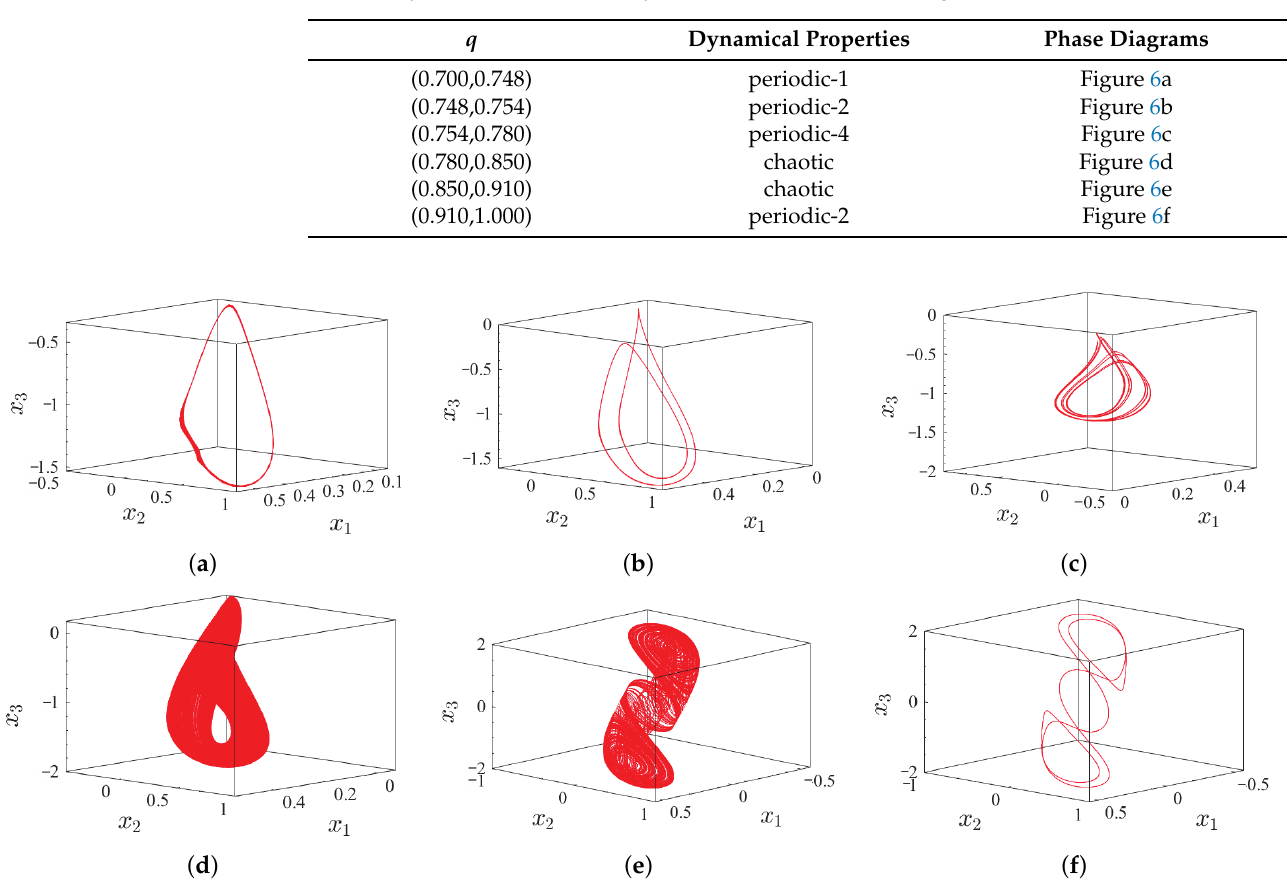
Figure 6. Phase diagrams of system (15) in x 1 of q = 0.75; ( c ) period-4 of q = 0.758; ( d ) single-scroll attractor of q = 0.80; ( e ) double-scroll chaotic attractor of q = 0.90; ( f ) period-2 of q = 0.95.